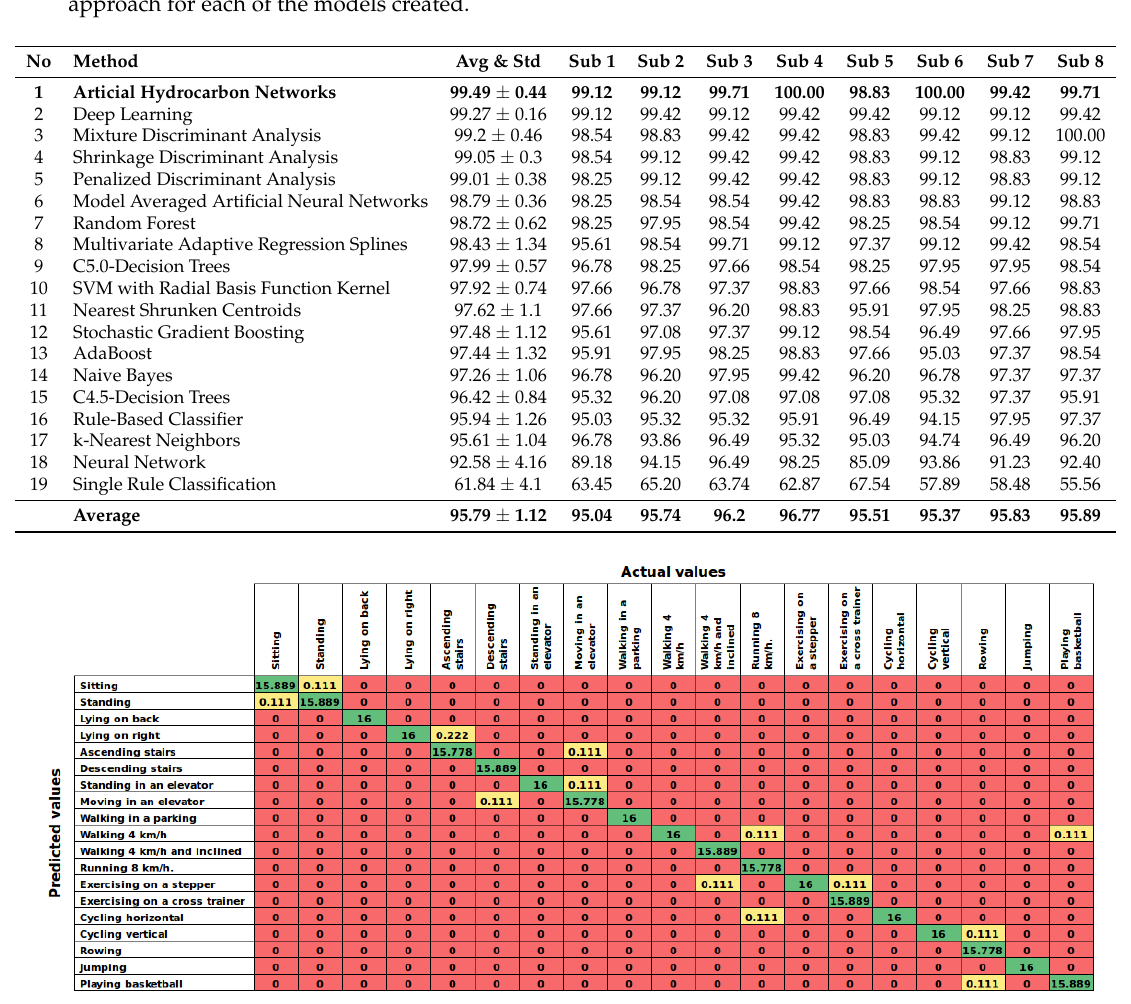
Figure 8. Results of case 3: Confusion matrix of the AHN-classifier in the cross-validation within a subject performance for user-dependent. Numbers represent the average of window counts in the eight